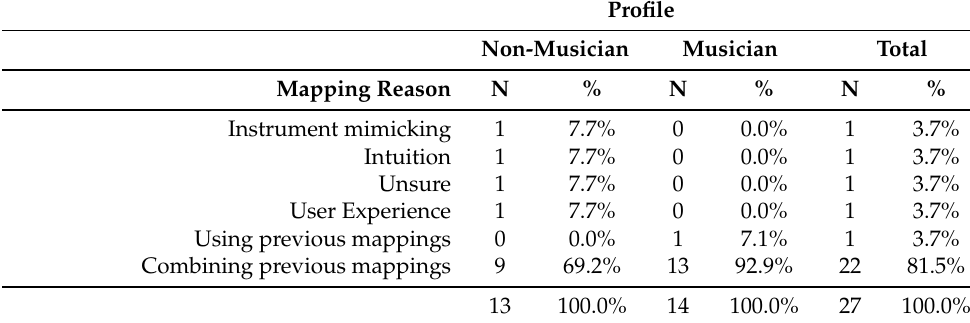
Table A25. Mapping rationale—stimulus